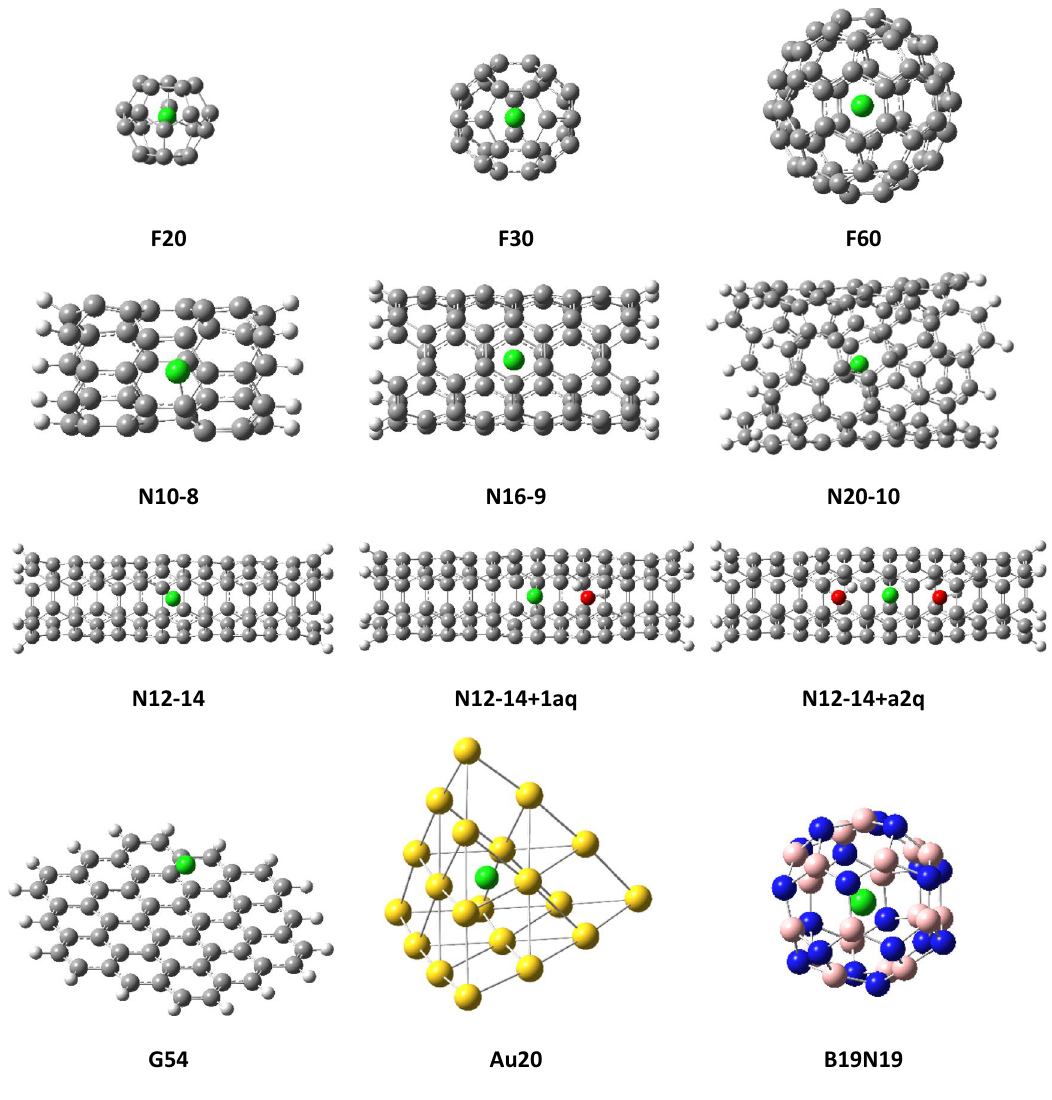
Figure 1. Nanostructures used in modeling of chlorine isotope